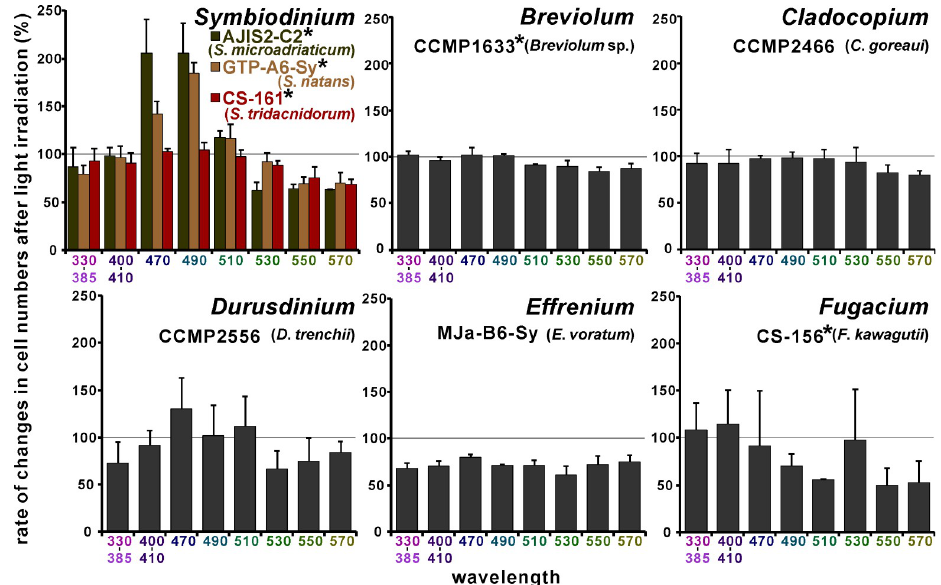
Fig 2. The phototaxis patterns of cultured Symbiodiniaceae strains. The 100% line indicates constant cell densities before and after irradiation. The mean and standard deviation of triplicate measurements (error bar) are shown. Asterisk on the shoulder of the strain name indicates significant relationship between wavelength and positive/negative phototaxis from GAM analysis.